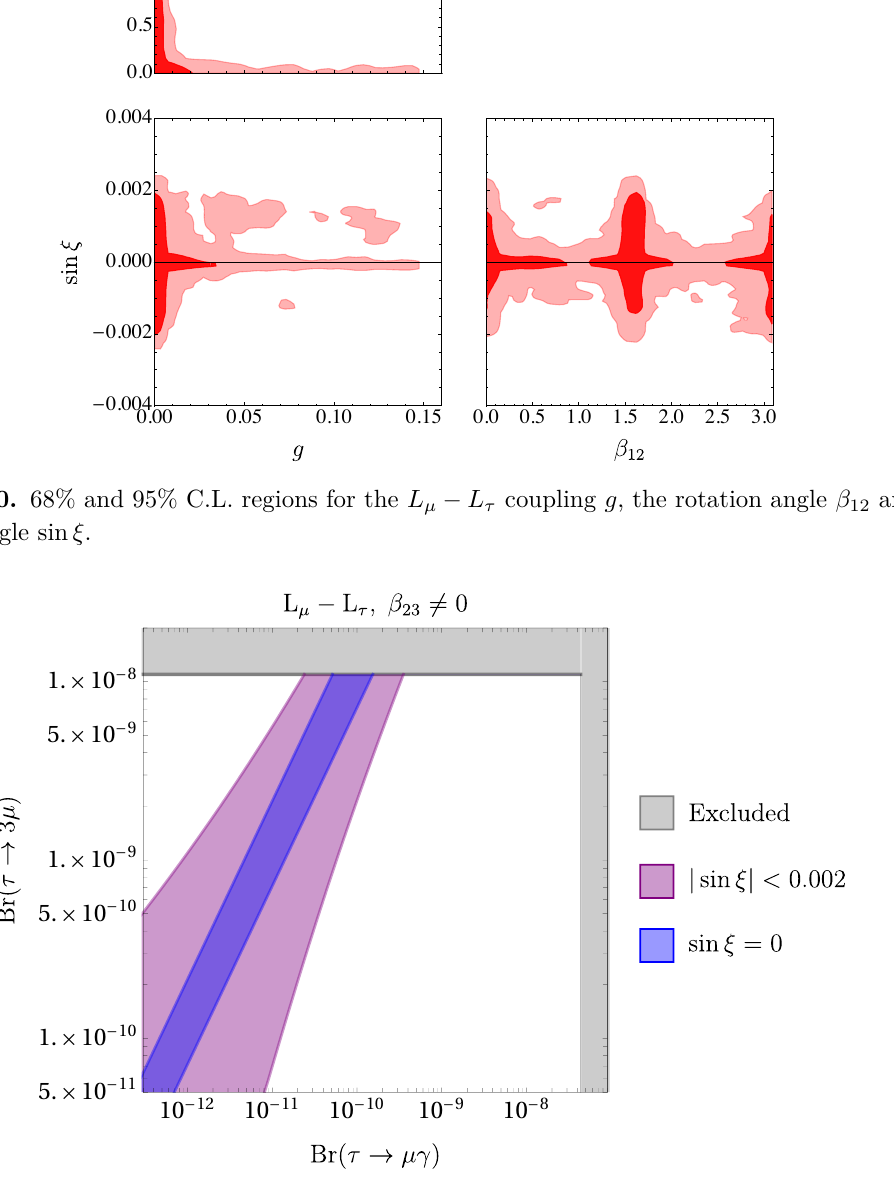
= 0 ). The colored regions are allowed 23 6